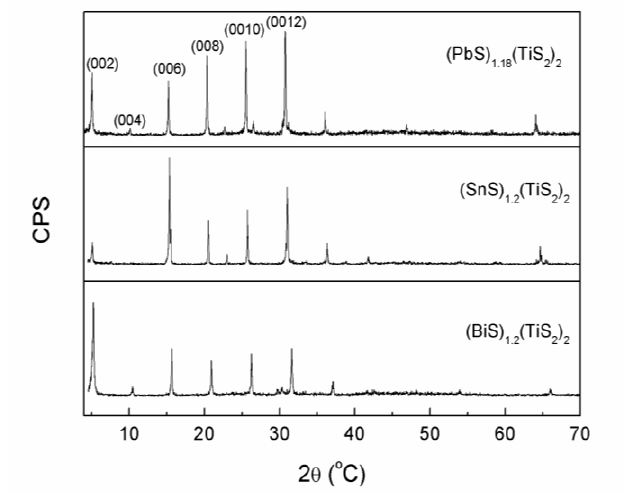
Figure 2. XRD patterns of (BiS) 1.2 (TiS 2 ) 2 , (SnS) 1.2 (TiS 2 ) 2 and (PbS) 1.18 (TiS 2 ) 2